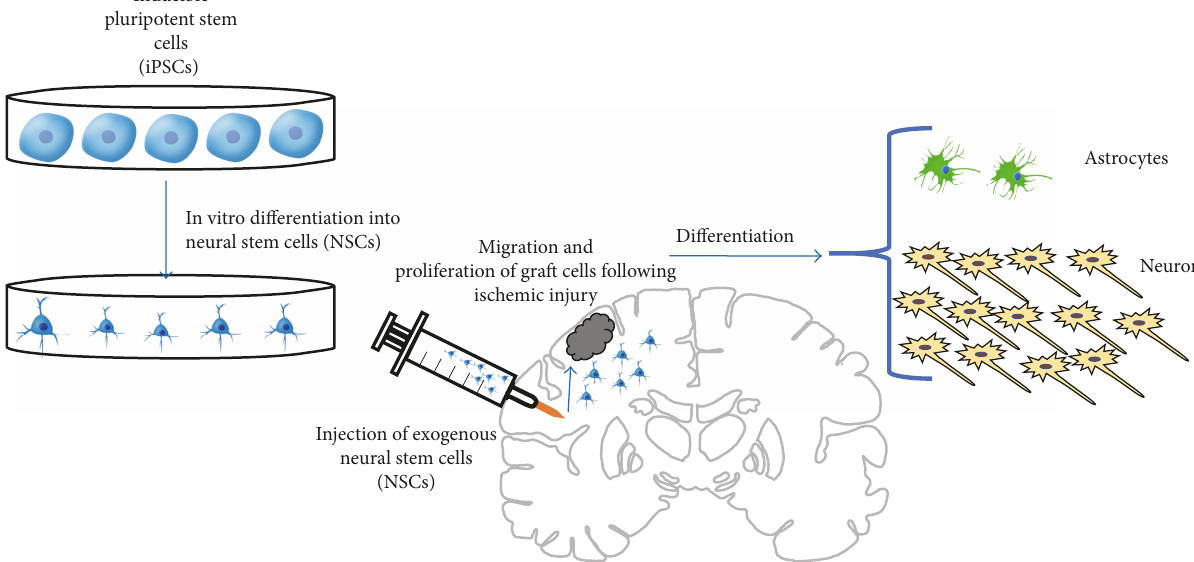
Figure 6: This fi gure demonstrates the capabilities of inducible pluripotent stem cells (iPSCs). Human iPSCs can be directed in vitro to the NSC phenotype. They are then injected into the cerebrum following MCAO and ischemic injury in rats. iPSCs are able to proliferate and di ff erentiate primarily into